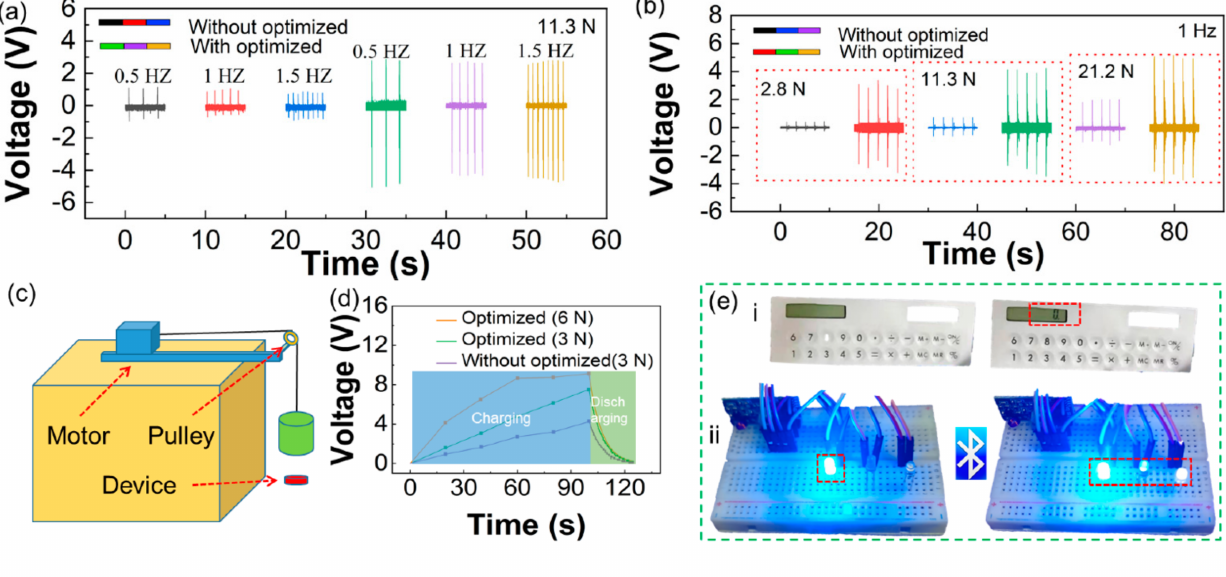
Figure 2. The comparison of properties of TENGs ( a ) The output voltage of TENGs at different frequencies. ( b ) The output voltage of TENGs at different forces. ( c ) The properties’ test platform. ( d ) Charging capacitor by TENGs. ( e ) The TENG drives micro electronic